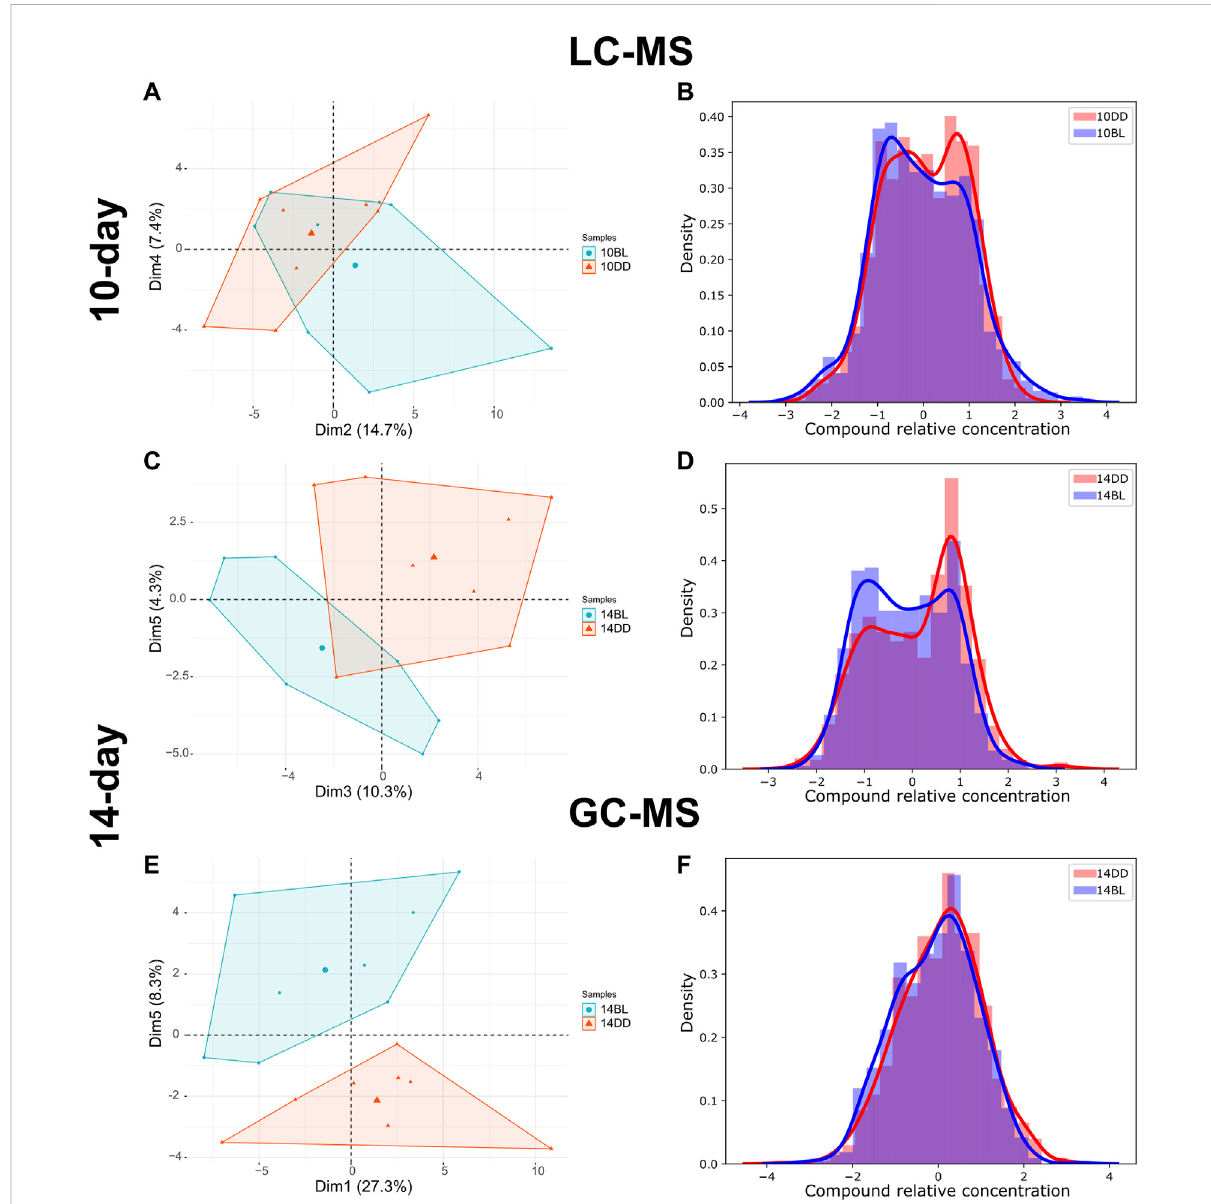
FIGURE 2 LC-andGCMSdetectedsigni fi cantmetabolomechangesinheadsof eya 2 fl ieskeptinBL. (A,C,E) PCAplotsofLC-MSorGC-MSmetabolitedata comparing fl ies kept for 10 or 14 days in BL versus DD. For additional data see Supplementary Figures S1 – S3. (B,D,F) Density plots for the same datasets. The distribution curve was calculated based on the histogram of the relative concentration distribution ( x -axis). The probability density function for the concentration distribution was used as the y